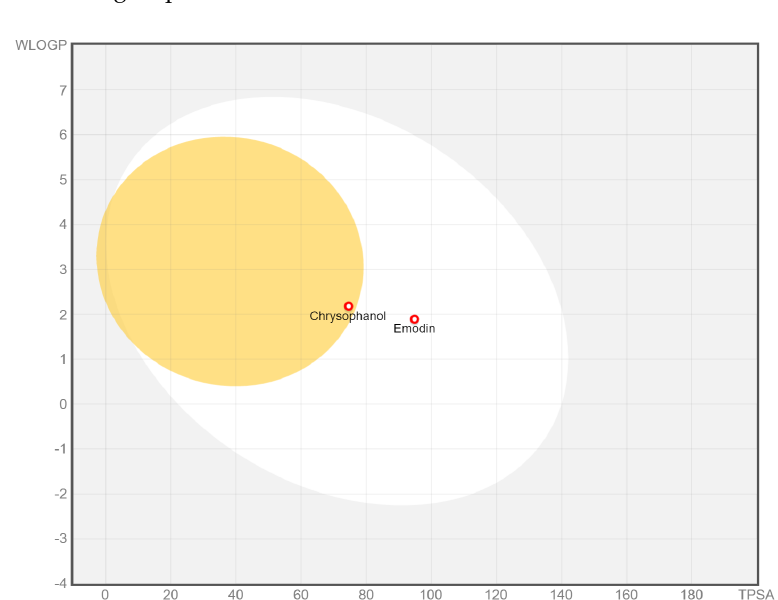
Figure 15. BOILED—EGG graph of compounds Emodin and Chrysophanol. The white component of a BOILED—EGG’s yolk indicates that molecules are passively absorbed by the gastrointestinal tract, while the yellow section indicates that chemicals are passively penetrate across the blood–brain barrier (BBB). Red dots indicate substances that the P-glycoprotein is not expected to remove